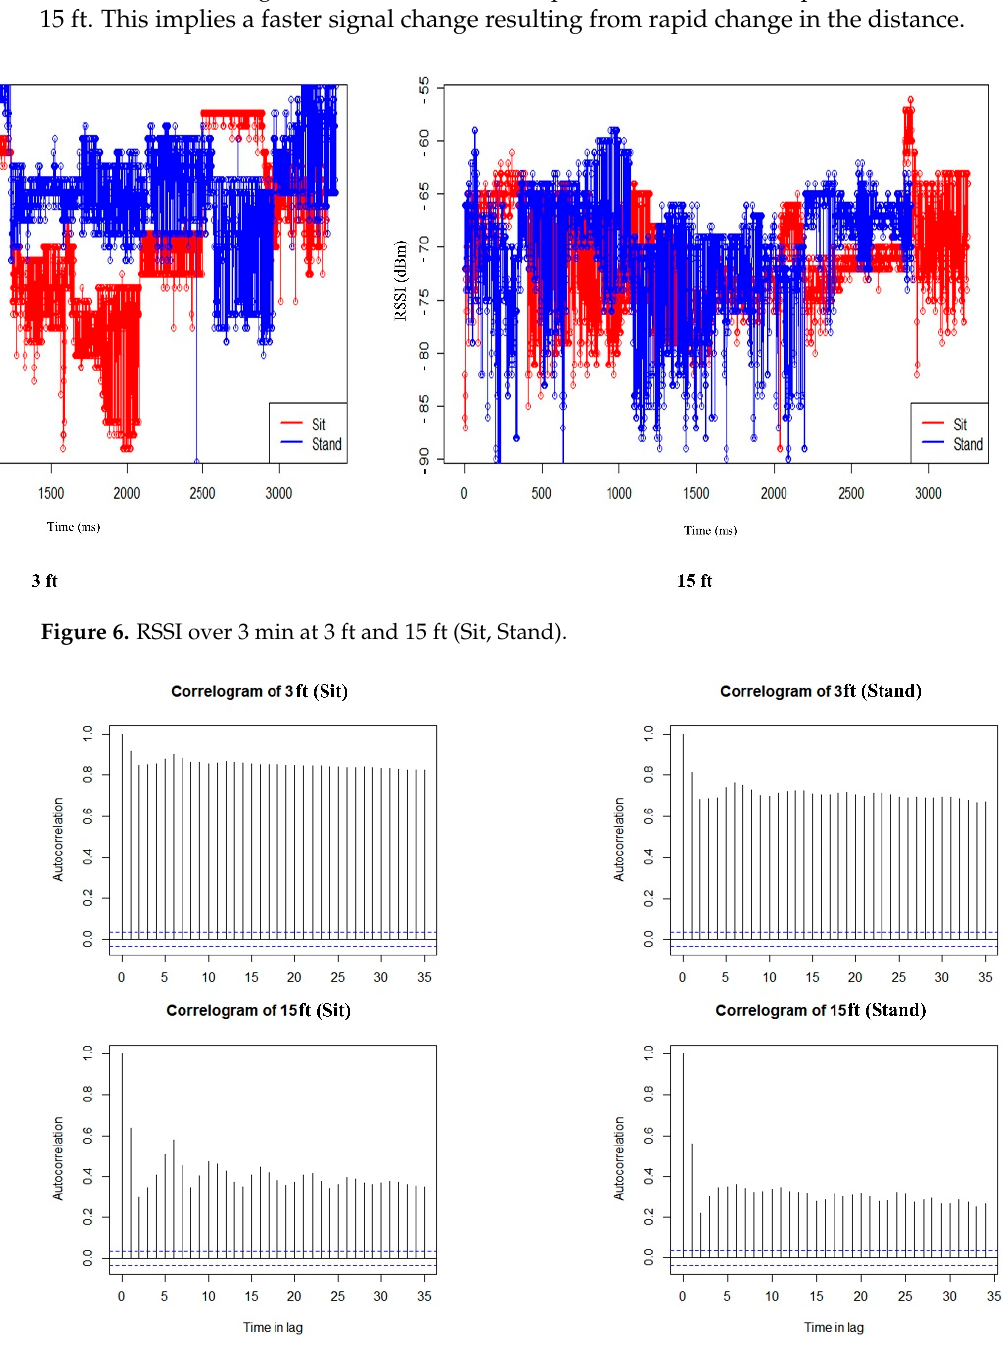
Figure 7. Correlograms of RSSI (3 ft and 15 ft, Sit and Stand). Meanwhile, the RSSI of the standing pose correlation coefficients at the same distance had smaller values than the sitting pose. The visual tests for this sample suggest the possibility of a stationary process. The higher the distance, the larger the autocorrelation co- efficient, and the smaller the distance, the smaller the autocorrelation coefficient,